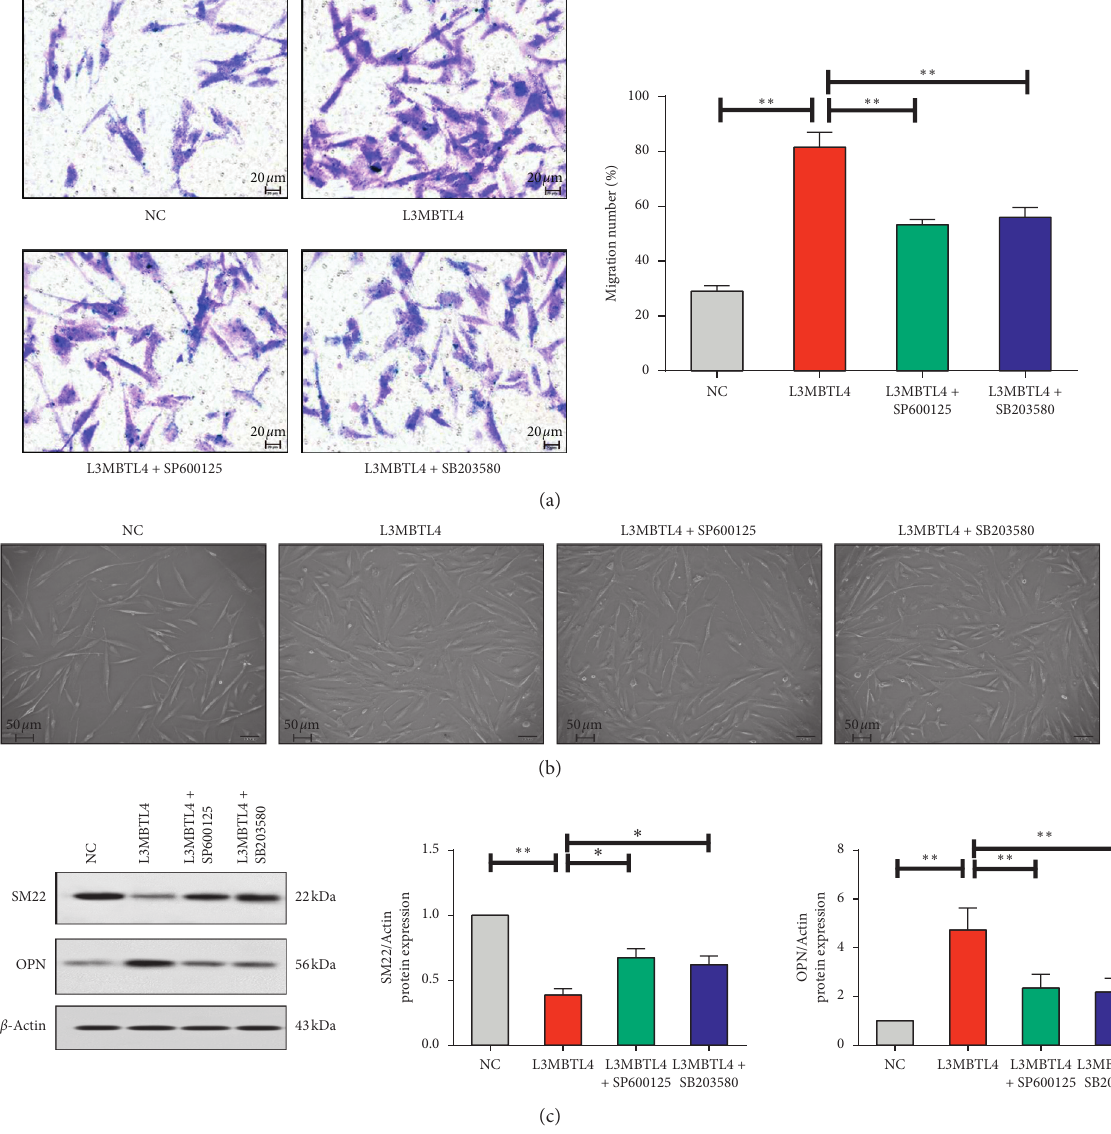
Figure 5: p38/JNK was required for VSMCs migration mediated by L3MBTL4 . (a) Boyden chamber migration assays were performed, and the number of migratory VSMCs was assessed by crystal violet staining ( n � 3). (b) Representative photomicrographs of cell morphology in the confluent cultured dishes of negative control, L3MBTL4 overexpressed cells, and cells treated with inhibitors. Scale bars are as shown. (c) Protein levels of SM-22 and OPN were measured by Western blot ( n � 3). ∗ p < 0 . 05; ∗∗ p < 0 . 01; ∗∗∗ p < 0 .